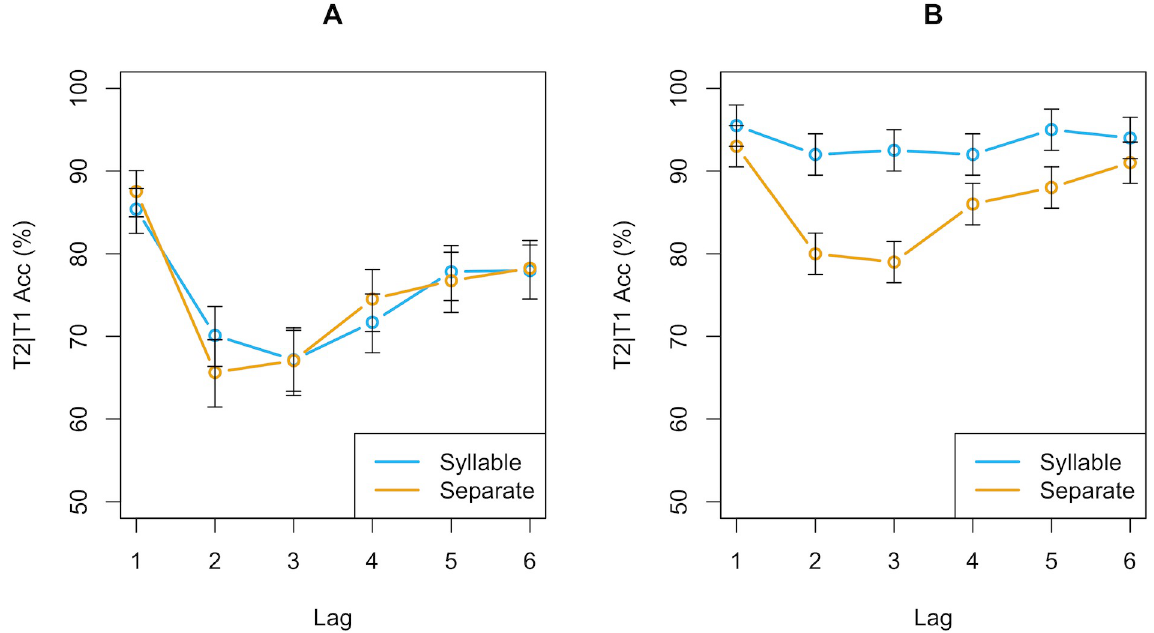
Fig 3. Comparison of replication and original study. (a) the mean T2|T1 accuracy per instruction condition over the six lags in our study. (b) the mean T2|T1 accuracy of the original study by Ferlazzo and colleagues [29]. In contrast to the original, performance in the ‘syllable’ condition (blue line in 3a) did not significantly differ from the AB in the ‘separate’ condition (orange line in 3a) in our study. Additionally, the difference in general accuracy between our data and the ‘separate’ condition of the original study (orange line in 3b) implies a difference in difficulty level of the two